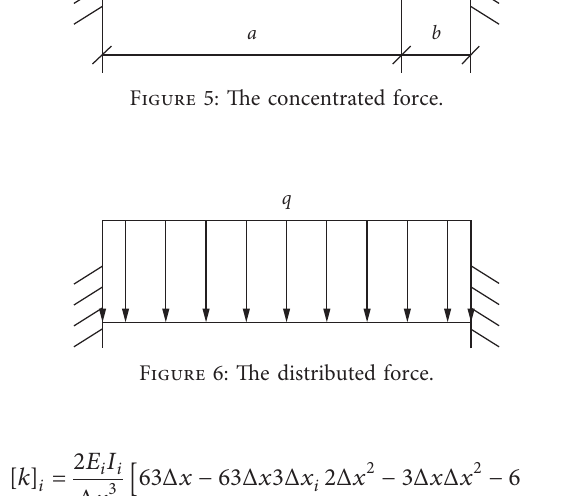
Figure 6: The distributed force.